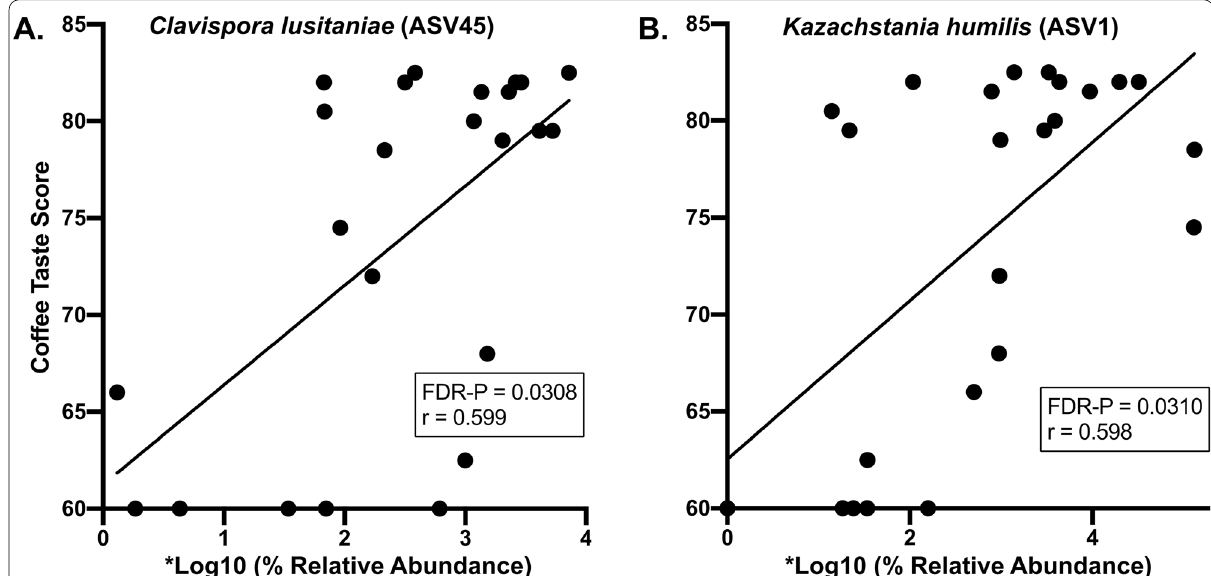
Fig. 3 Abundant fungi that positively correlated with coffee taste scores. Pearson correlation analyses were used to identify the abundant fungal ASVs that positively correlated with coffee taste scores. Average ASV relative abundances were obtained using an Illumina‑based sequence analysis of the fungal rRNA ITS region. *Relative abundance values were multiplied by 269,972 before the log10 operation such that the final non‑zero values were greater than zero. ASV numbers are indicated in parentheses to the right of the taxa. The average relative abundances of these fungi were: ASV1, 2.8%; ASV45, 2.5%. Correlation coefficient (r) and probability value (P) are shown (n =